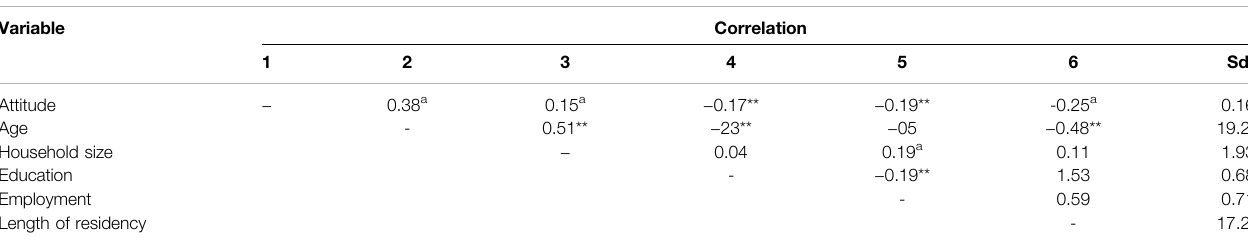
TABLE 7 | Summary of correlations between variables.